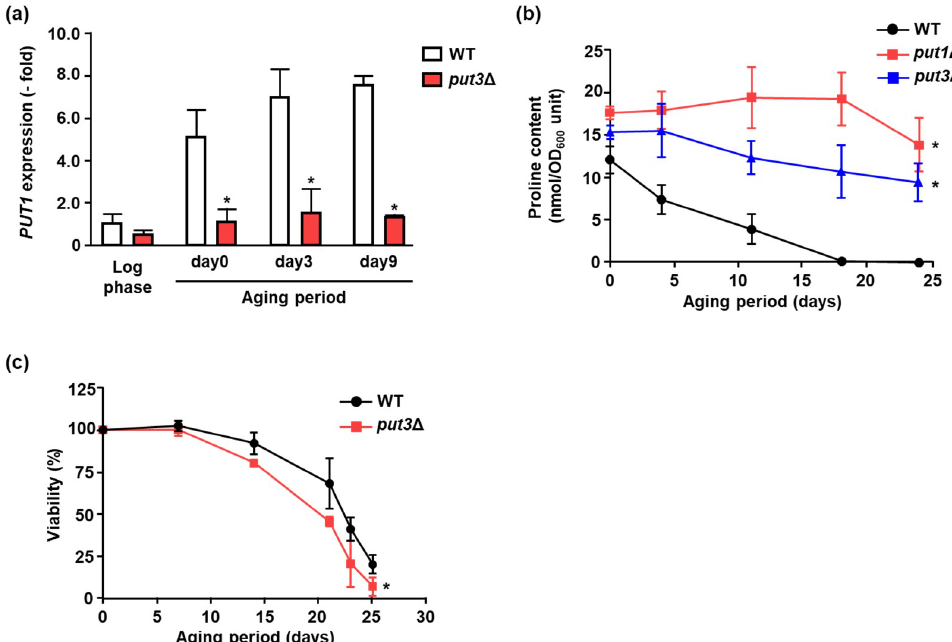
Figure 4. Longevity regulation mediated by PUT1 induction. ( a ) PUT1 expression in WT and put3 ∆ upon aging period. PUT1 mRNA was determined by qPCR. Cells in log phase were collected after the cultivation for 12 h. Data are presented as means ± SD ( n = 3) and statistical significance was determined by Student’s t -test. * p < 0.05, vs. WT. ( b ) Proline content in WT, put1 Δ and put3 Δ upon aging period. After cultivation for the indicated time, proline content was measured by using an amino acid analyzer. Data are presented as means ± SD ( n = 3) and statistical significance was determined by two-way ANOVA with Tukey’s test. * p < 0.05, vs. WT. ( c ) Chronological survival curves of WT, put3 Δ. Chronological aging was determined by counting the number of colony-forming units. Data are presented as means ± SD ( n = 5) and statistical significance was determined by two-way ANOVA with Tukey’s test. * p < 0.05, vs. WT.